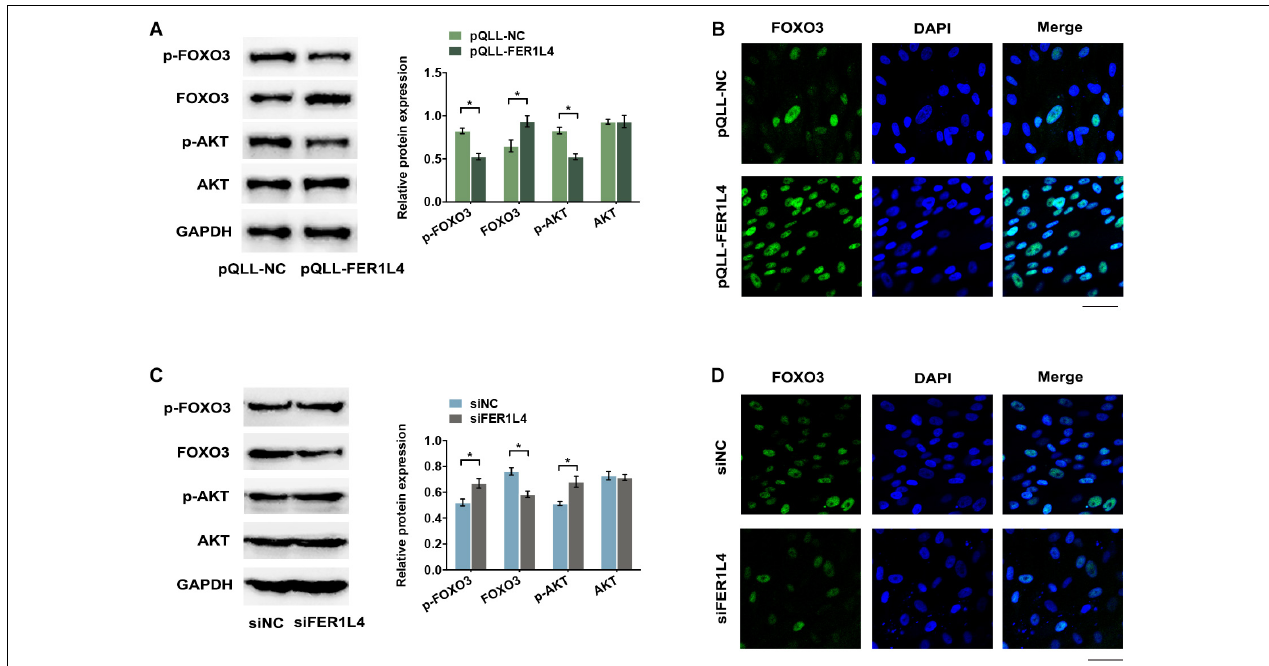
FIGURE 4 | FER1L4 inhibited the phosphorylation of AKT and increased the nuclear translocation of FOXO3. Cells were transfected with FER1L4 vector (pQLL-FER1L4) or FER1L4 siRNA (siFER1L4) to overexpress or knock down its expression. (A) Western blot analyses of p-AKT, AKT, p-FOXO3, and FOXO3 in FER1L4 overexpression group. Histograms show the quantification of the band intensities. (B) Images of FOXO3 immunofluorescence staining in FER1L4 overexpression group. Scale bar: 50 µ m. (C) Western blot analyses of p-AKT, AKT, p-FOXO3, and FOXO3 in FER1L4 knockdown group. Histograms show the quantification of the band intensities. (D) Images of FOXO3 immunofluorescence staining in FER1L4 knockdown group. Scale bar: 50 µ m. Data are presented as the mean ± SD ( n = 3, * p <